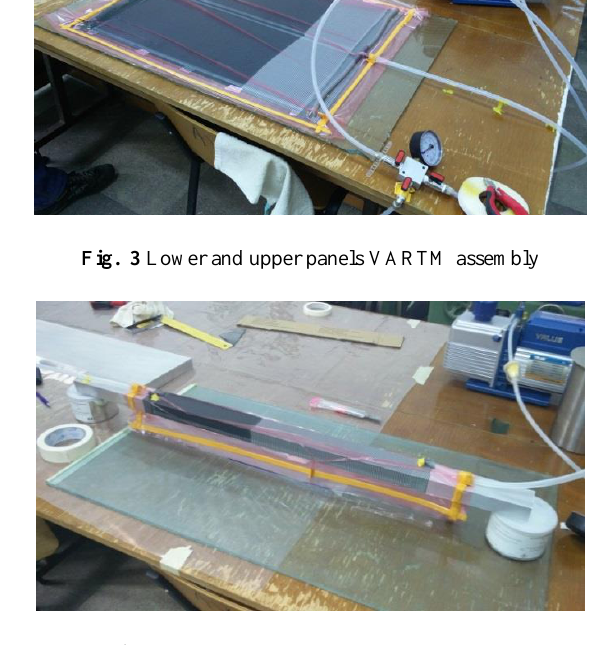
Fig. 4 The C section spar VARTM assembly